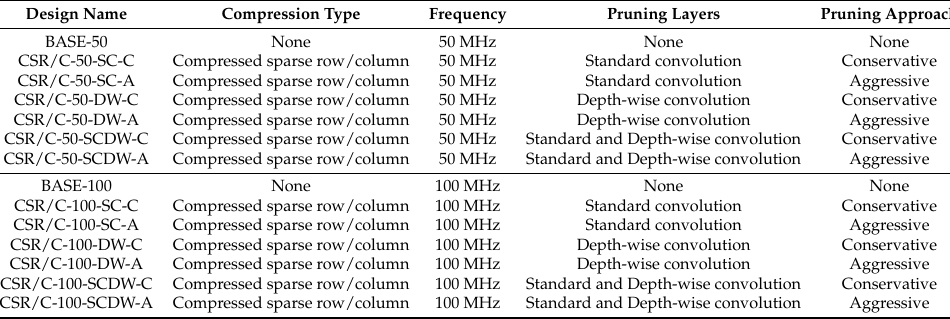
Table 2. HLS configuration and parameters of each implemented